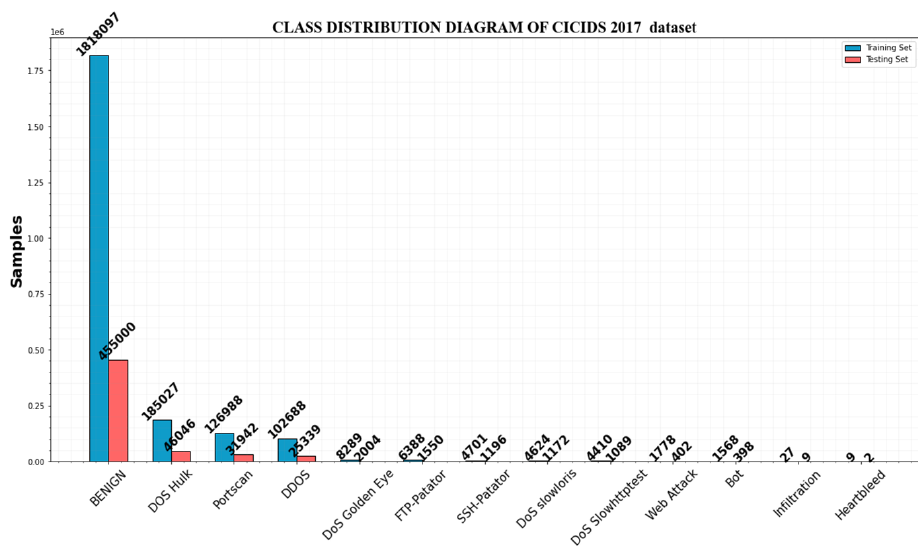
Figure 5. Class distribution of the CICIDS2017 dataset. Table 7. Features of the CICIDS2017 dataset.